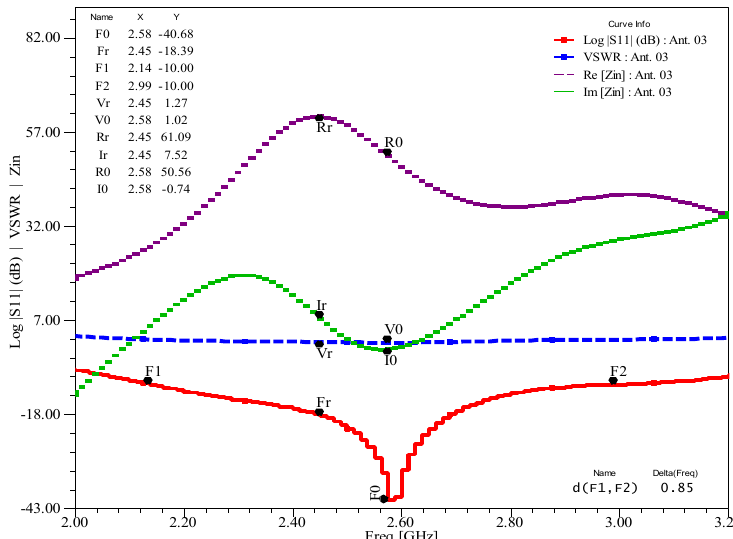
Figure 12. Reflection coefficient, VSWR, and input impedance of Slot antenna 3 versus frequency.